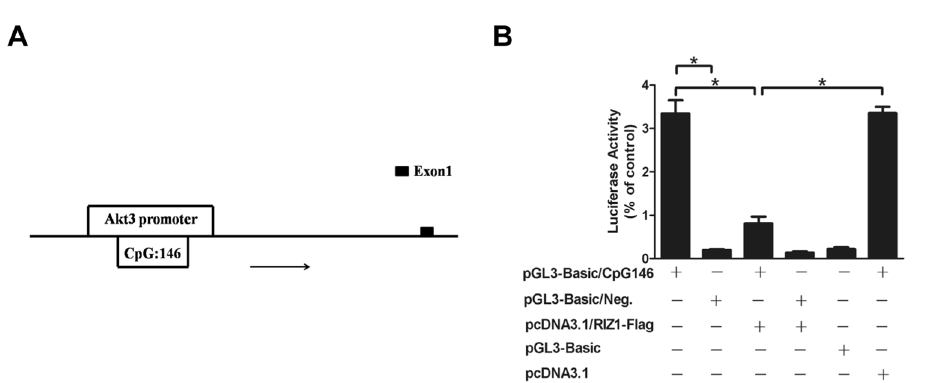
Figure 2. RIZ1 on Akt3 gene promoter activity. ( A ) Schematic diagram of mouse Akt3 gene promoter were found from http://www.ensembl.org, which included the CpG island 146 (Data were indentified from University of California Santa Cruz (UCSC)). ( B ) The Akt3 promoter plasmid pGL3-Basic/CpG146 and the control plasmid pGL3-Basic/Neg. (negative control) was co-transfected with RIZ1-Flag expression plasmid into HEK293 cells. Dual luciferase activity was measured by a luminometer after 48 h transfection. The values represent means ± SD; n = 3; * p <